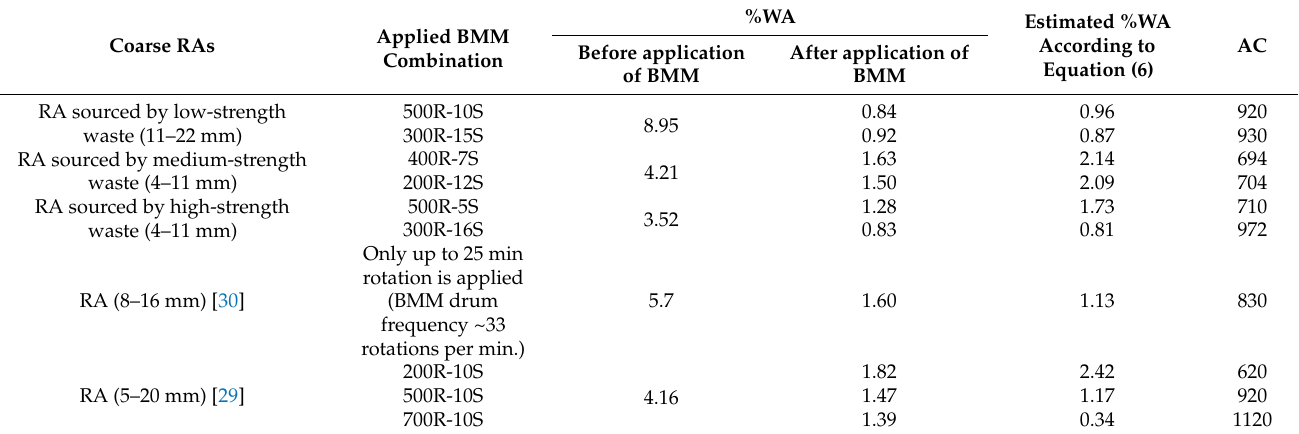
Table 7. Water absorption values of